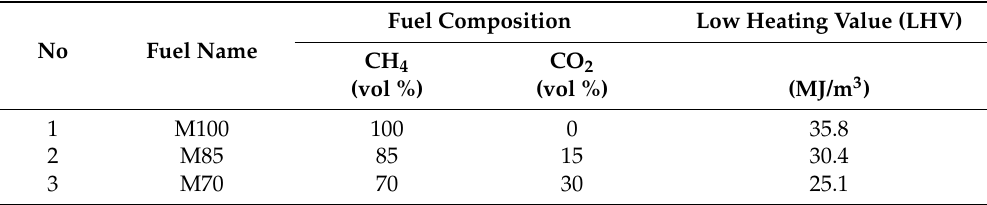
Table 2. Composition and main parameters of fuels.